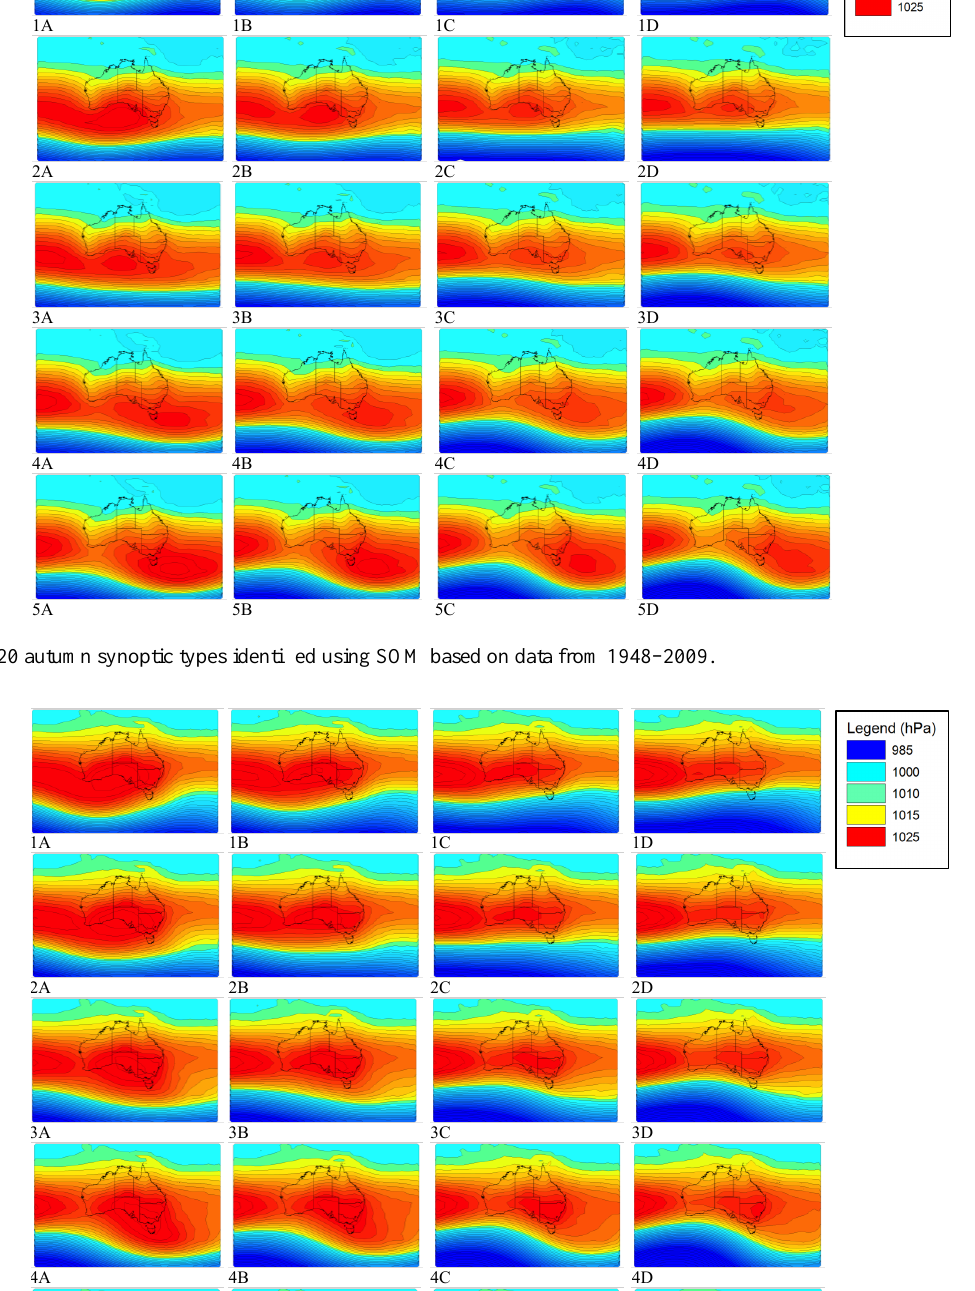
Hydrol. Earth Syst. Sci., 18, 2235–2256,